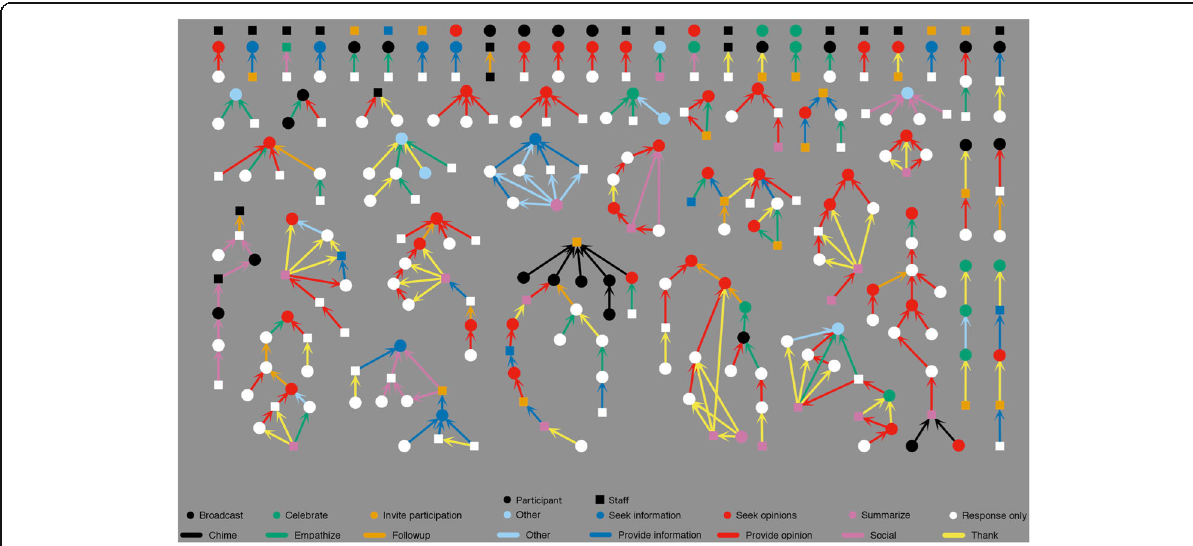
Fig. 6 Network diagram of connection between 281 messages sent on listserv in year following workshop, all